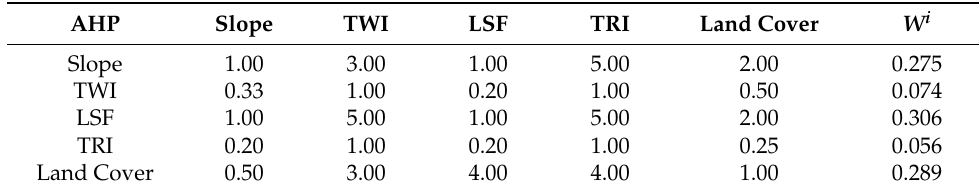
Table 3. The pairwise comparison matrix for LS factors: 1—equal importance, 2—weak importance, 3—moderate importance, 4—moderate plus, 5—strong importance.